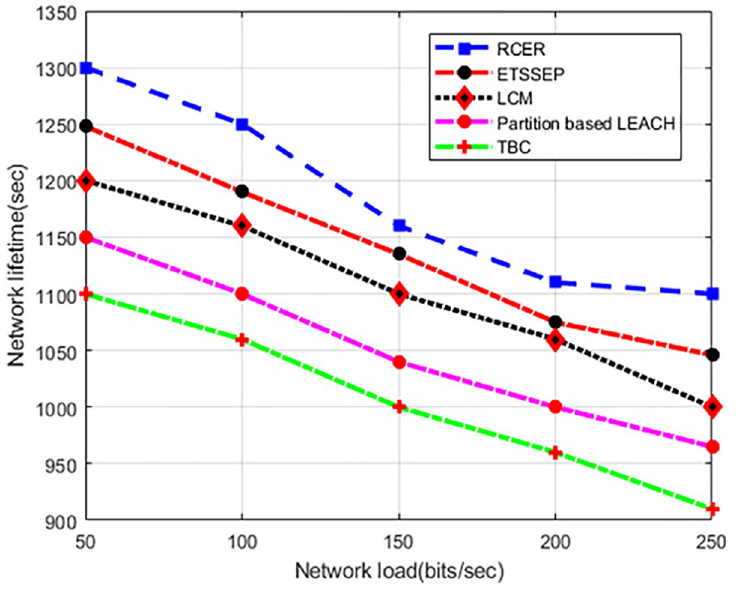
Fig 9. Network lifetime in varying network load.